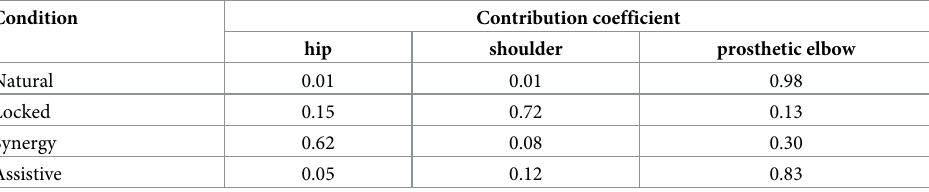
Table 1. Transformation of IK weights to “Contribution coefficients” for the second